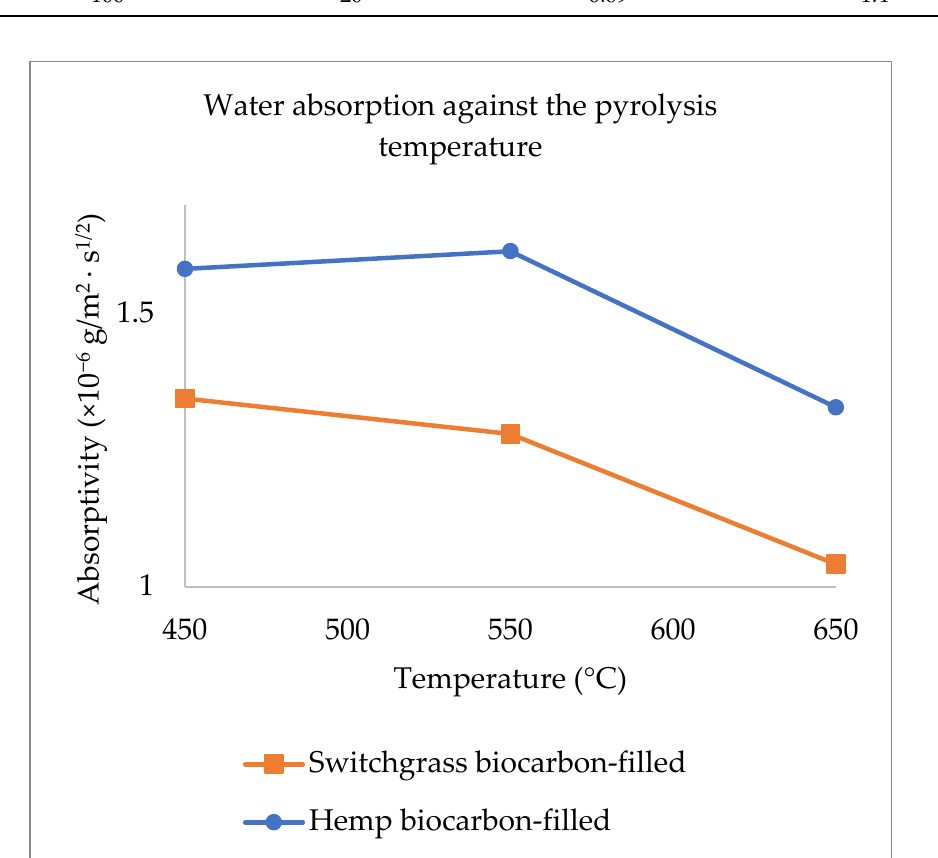
Figure 12. Main effect of the pyrolysis temperature on the water absorptivity.